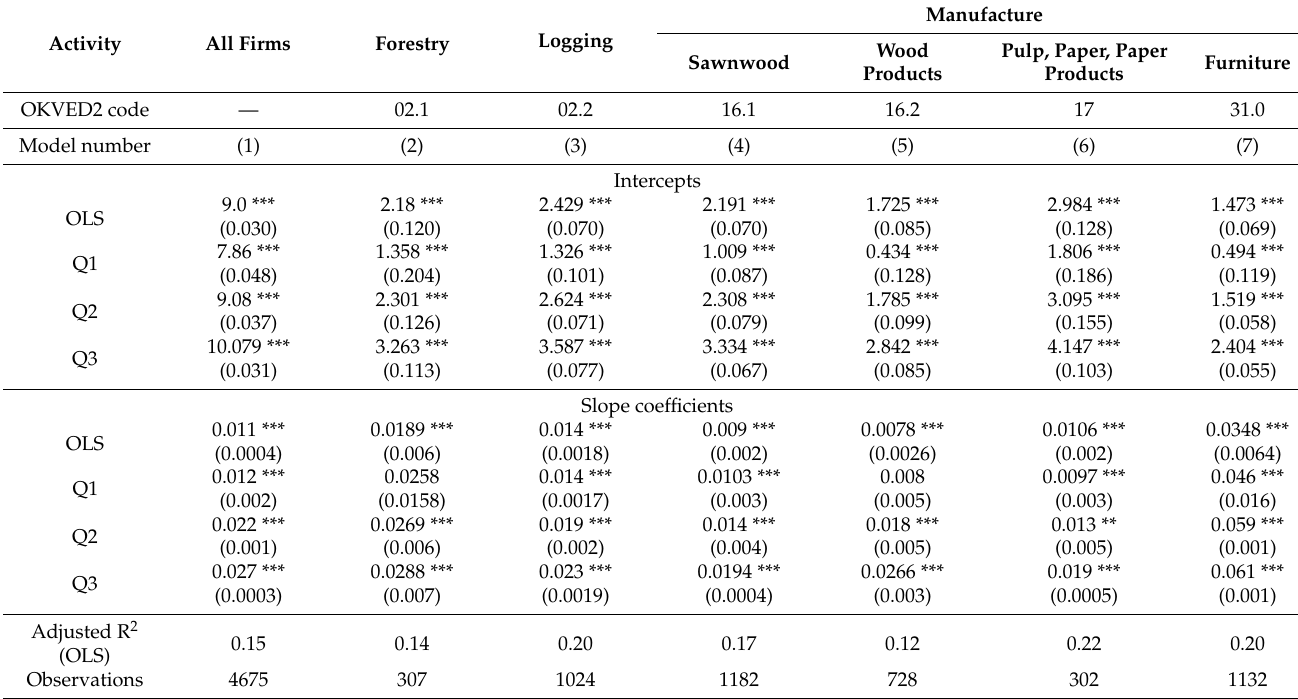
Table 5. OLS and quantile regression results for Asian Russian companies by activity type.